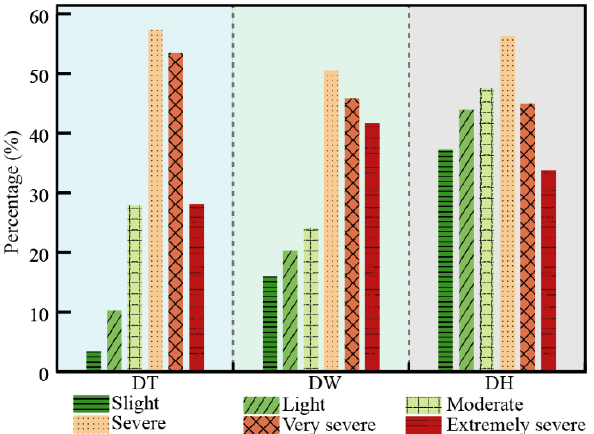
Figure 8. Areal proportions of six erosion intensities between dry valleys and counties (DT: dry– temperate valley, DW: dry–warm valley, and DH: dry–hot valley) .